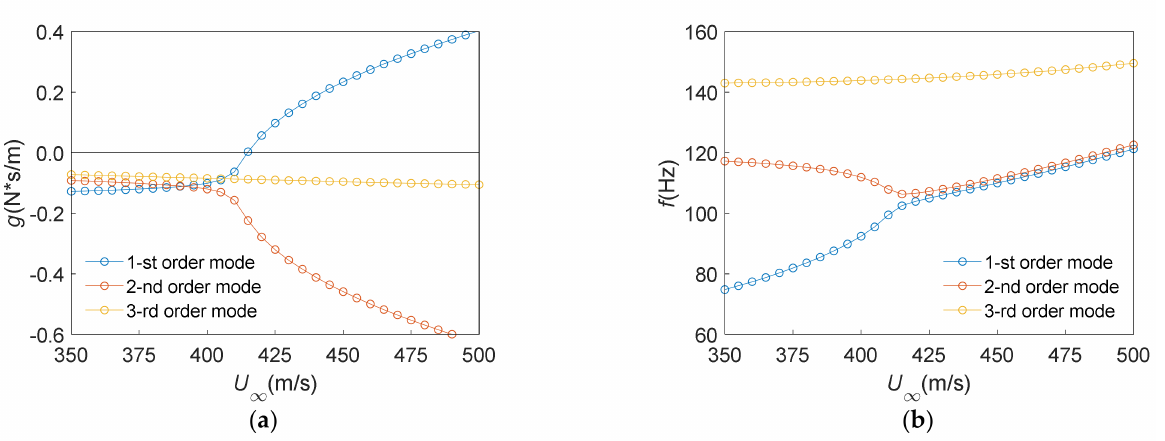
Figure 8. Results of flutter calculation (LRT): ( a ) U − g ; ( b ) U − f .